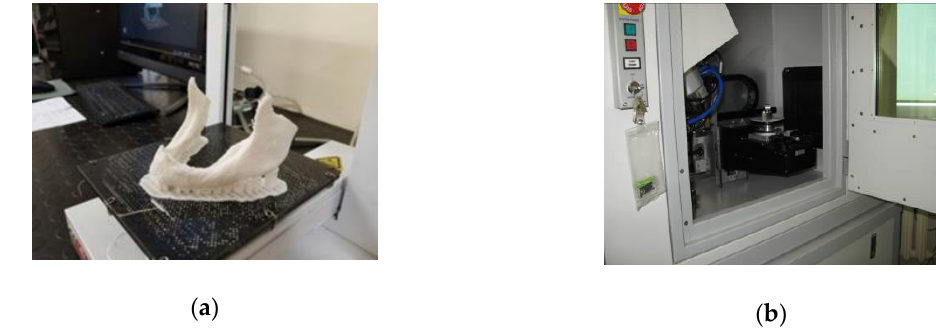
Figure 2. The process of 3D printing and geometry digitalization: ( a ) Prusa MK3s 3D printer; ( b ) CT160Xi Benchtop tomography system.